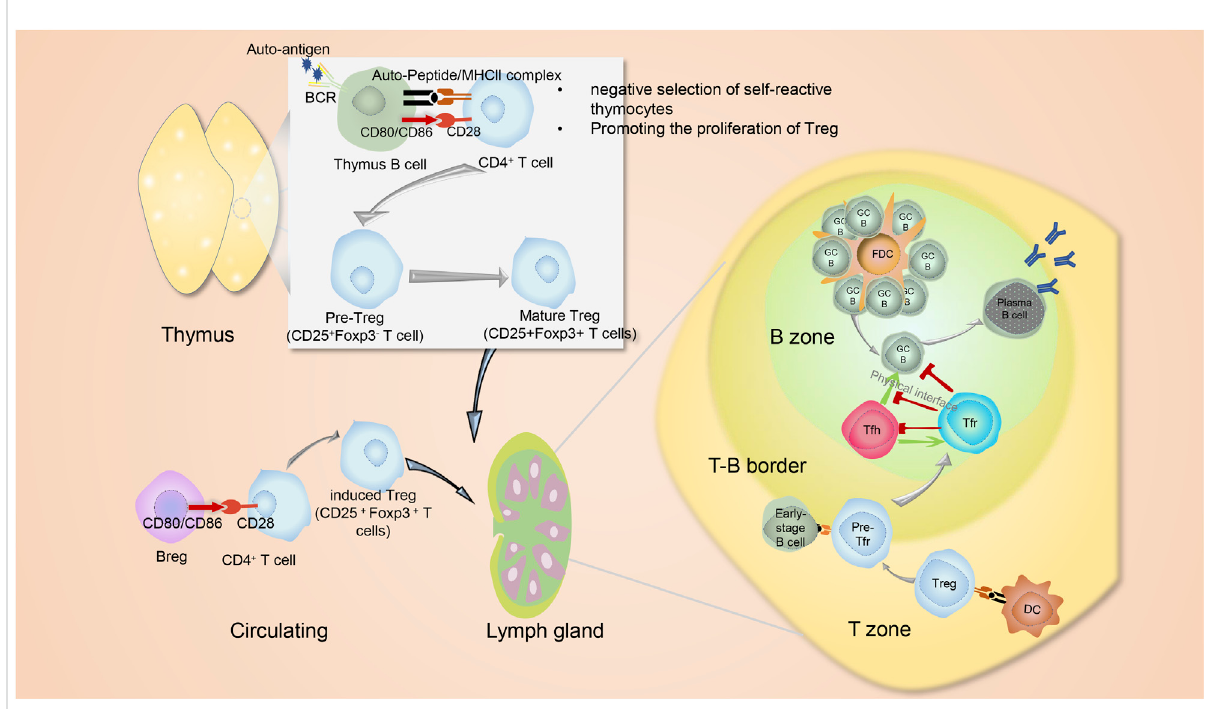
FIGURE 1 The interplay between B cells and Treg. In addition to thymic mTEC and BM-DCs that act as APCs to promote to produce Tregs, thymus Bcells expressing CD80, CD86 and MHC II, also function like APC cells. Their BCRs capture autoantigens. Interaction of TCR-MHC II-peptide and CD28 − CD80/CD86 between B cells and CD4 + T cells lead to the production of thymic CD25 + Foxp3 - pre-Tregs, which then advance into Foxp3+ mature Tregs. In the periphery, naive CD4 + Foxp3 - T cells may interact with immune cells such as Breg and then transform into periphery- derivedTregs.Boththymus-derivedTregsandperiphery-derivedTregswouldcirculateintolymphoidorgans,wheretheywilltransformintoTfrcells and exert suppressive functions on the humoral immunity via controlling metabolic pathways of both B cells and Tfh cells. The differentiation of Tfr cells occurs in a stepwise manner. The fi rst step involves interactions with dendritic cells (DCs) that initiate imprinting on the Tfr cell development, and the second step is interaction with B cells to strengthen Tfr cell signaling. Tfh, Tfr and GC B cells own complicated and elaborate regulatory interrelationship. Tfh cells deliver positive function to B cells for af fi nity-matured antibody production. Besides, Tfh cells themselves help drive the formation of Tfr cells. Conversely, Tfr cells can not only act directly on Bcells but also suppress Tfh cells to indirectly act on B cells by preventing the co-stimulation and cytokines needed to promote B cell proliferation. Furthermore, Tfr cells can physically disrupt of Tfh-B cell communication. The fi gures are portrayed with the help from website Servier Medical Art